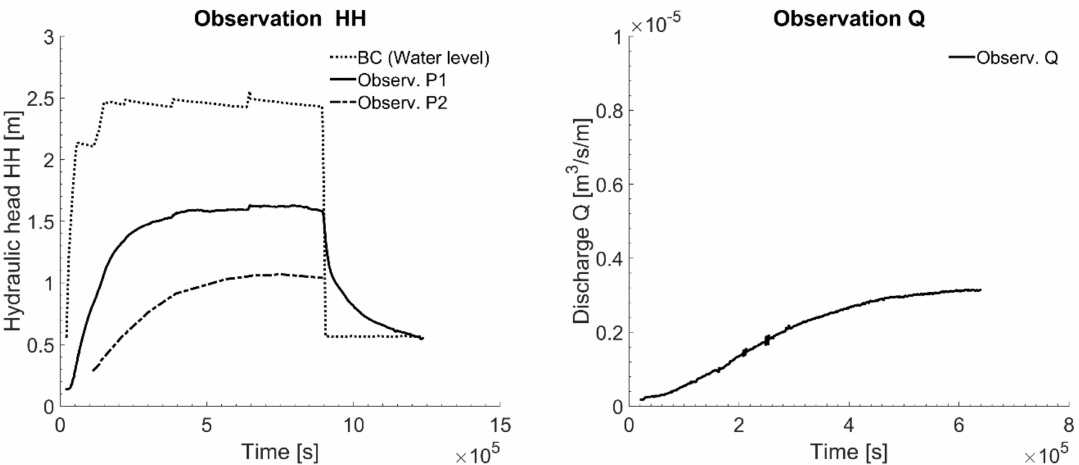
Figure 4. Observation data for the model fitting on cross-section D, recorded hydraulic head HH and discharge Q